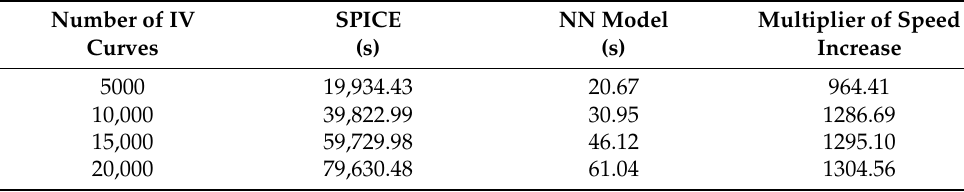
Table 5. Time comparison between NN model prediction and SPICE simulation.